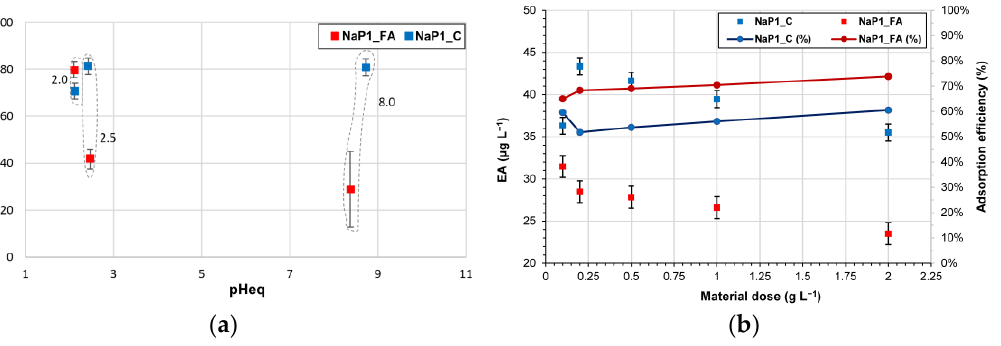
Figure 5. The effect of ( a ) pH and ( b ) dosage on erythromycin removal. The values on the graph indicate the initial pH.